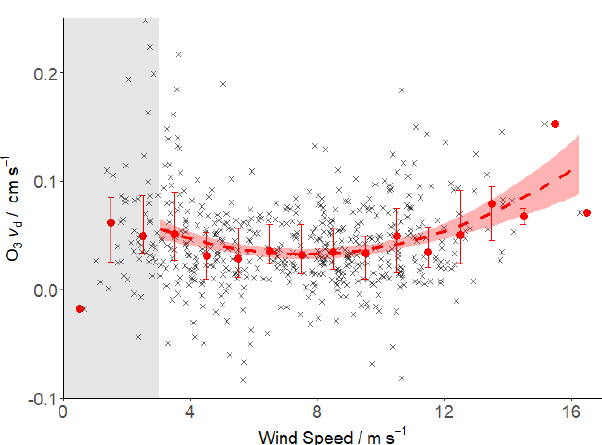
Figure 8. Deposition velocity dependence on wind speed. 20min values are shown in grey, with bin-averaged medians (1ms − 1 ) and interquartile ranges shown as red dots with bars. A second-order polynomial fit is plotted as a dotted red line, with a 95% confidence interval (red shaded area). The grey region below 3ms − 1 indicates values removed by the wind speed filter (Sect. 2.4) that are not in- cluded in the fit.